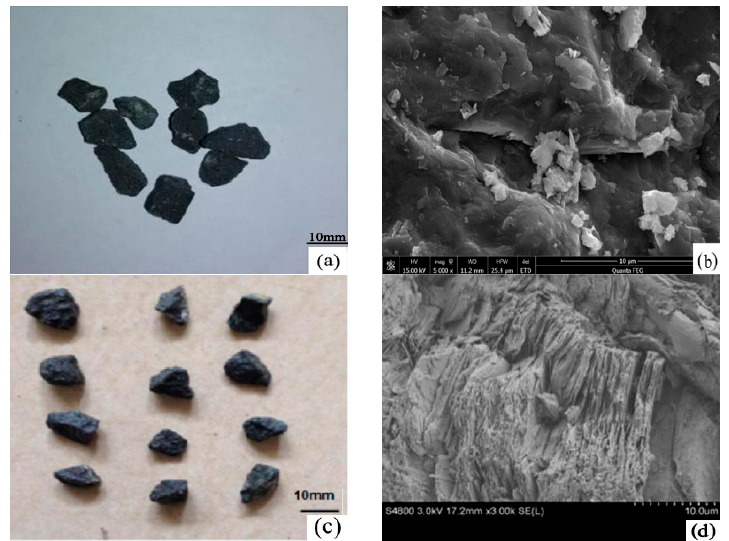
Figure 2. Macro and micro morphology of basalt and limestone: ( a , b ) basalt; ( c , d ) limestone.